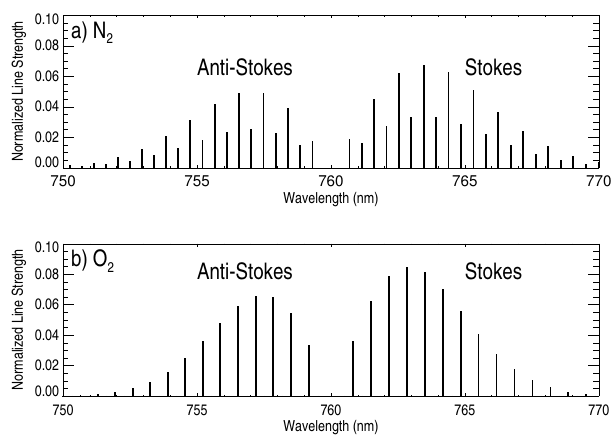
Fig. 1. Rotational-Raman spectra of (a) N 2 and (b) O 2 for excitation wavelength 760nm. Line strengths are normalized such that the sum over all lines is equal to unity.